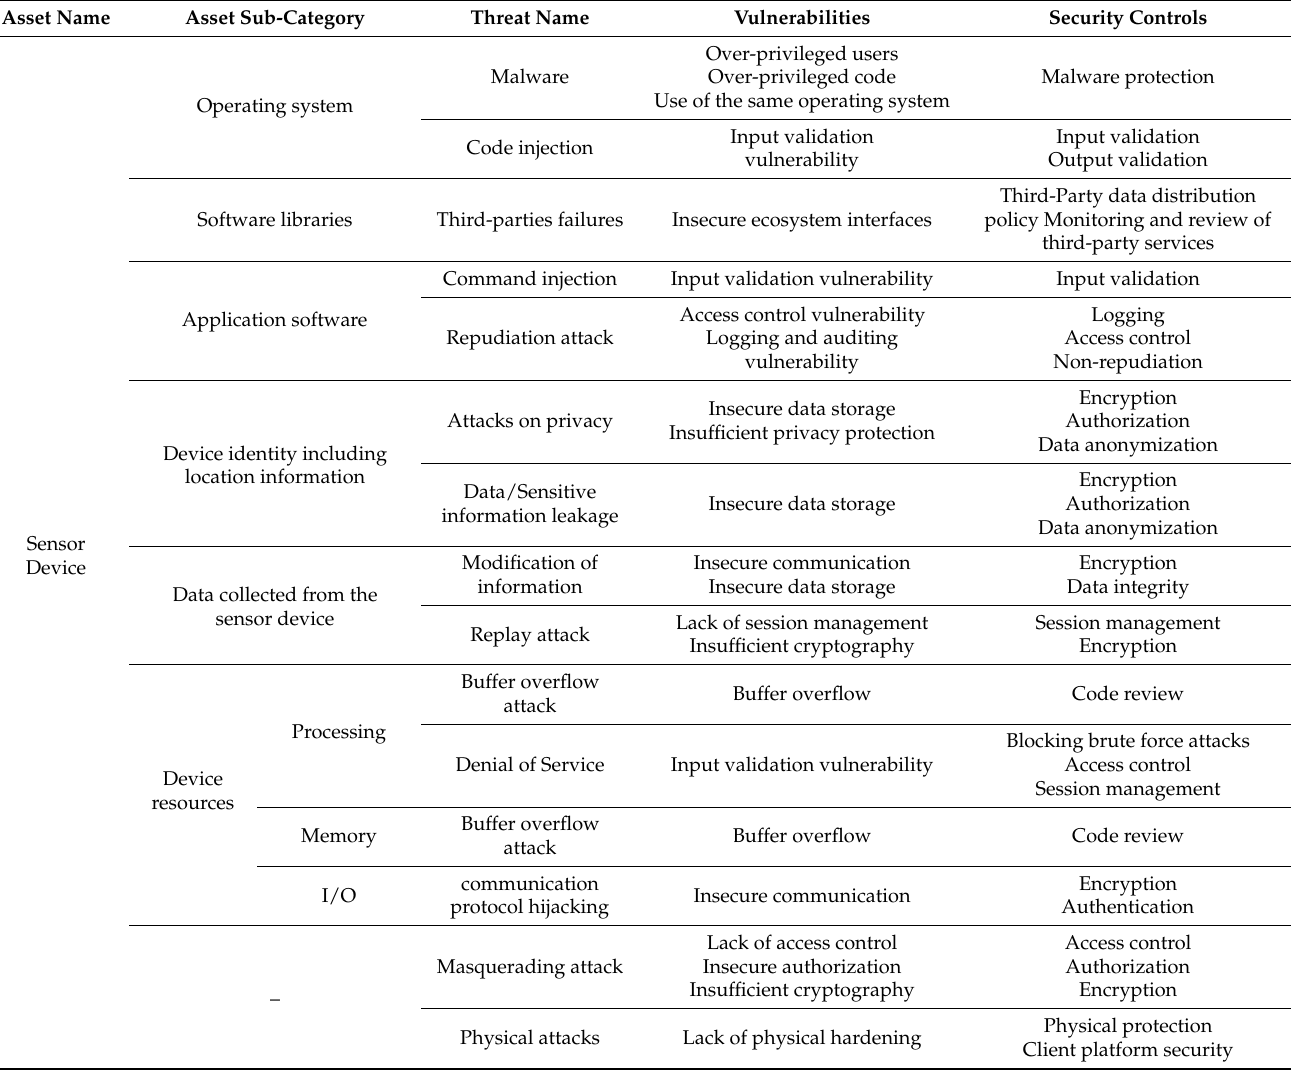
Table A1. List of assets, threats, vulnerability and security controls for wban application. Asset